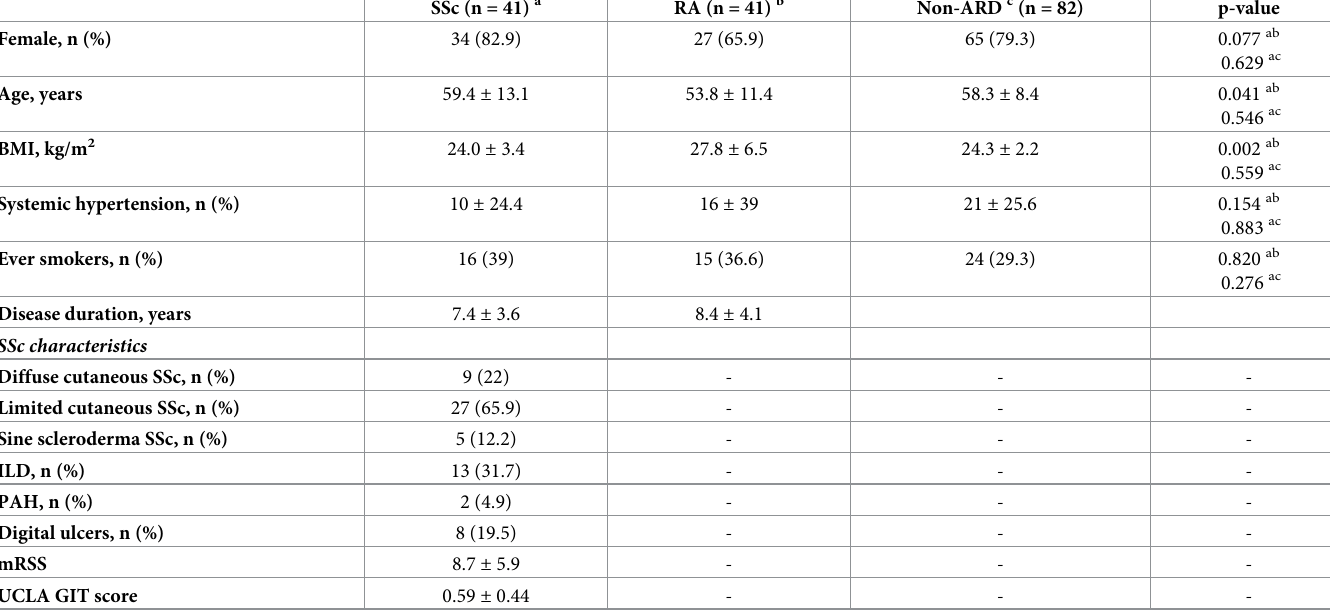
Table 1. Characteristics of the study